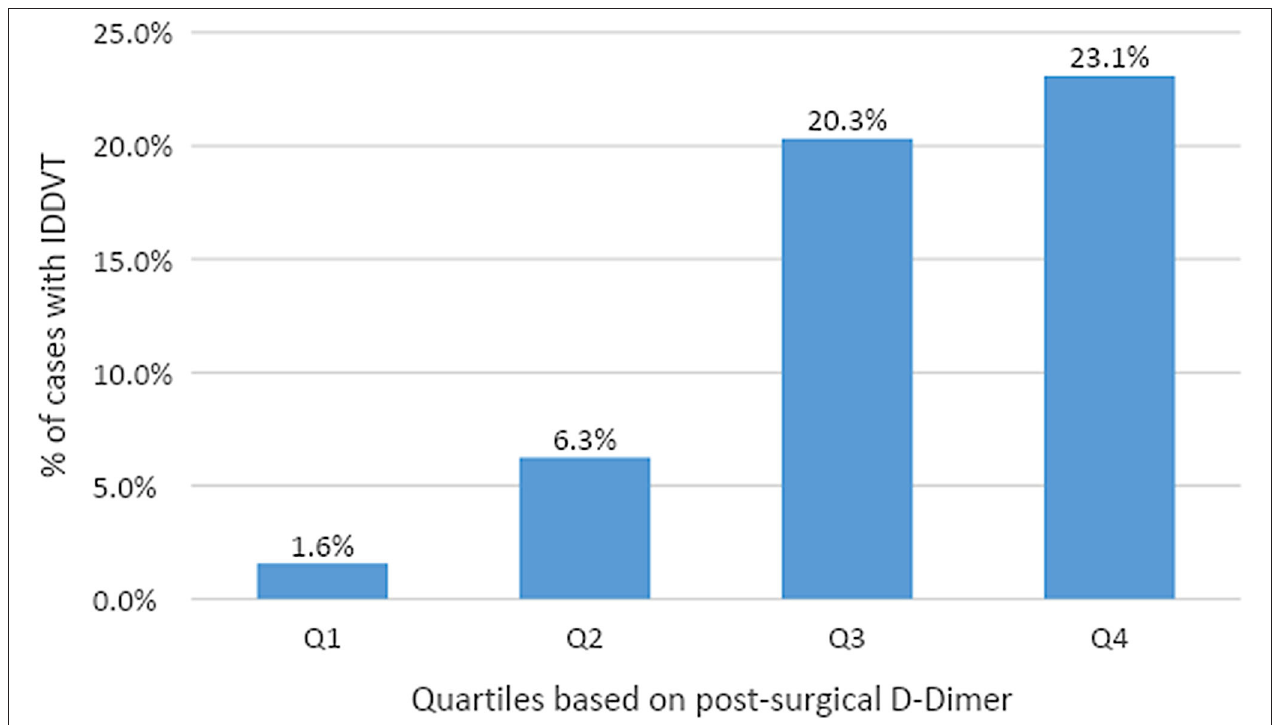
FIGURE 2 | Rates of IDDVT by quartile of post-surgical D-Dimer. 1st quartile (0–306ng/mL) had 1 case among 64 patients. 2nd quartile (306–438ng/mL) had 4 cases among 64 patients. 3rd quartile (438–717ng/mL) had 13 cases among 64 patients. 4th quartile ( > 717ng/mL) had 15 cases among 65 patients.